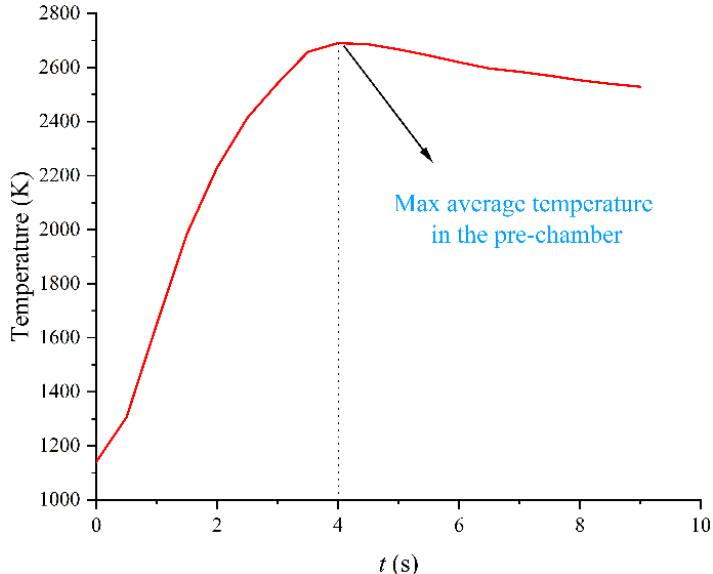
Figure 12. The average temperature of the pre-chamber varies with time.